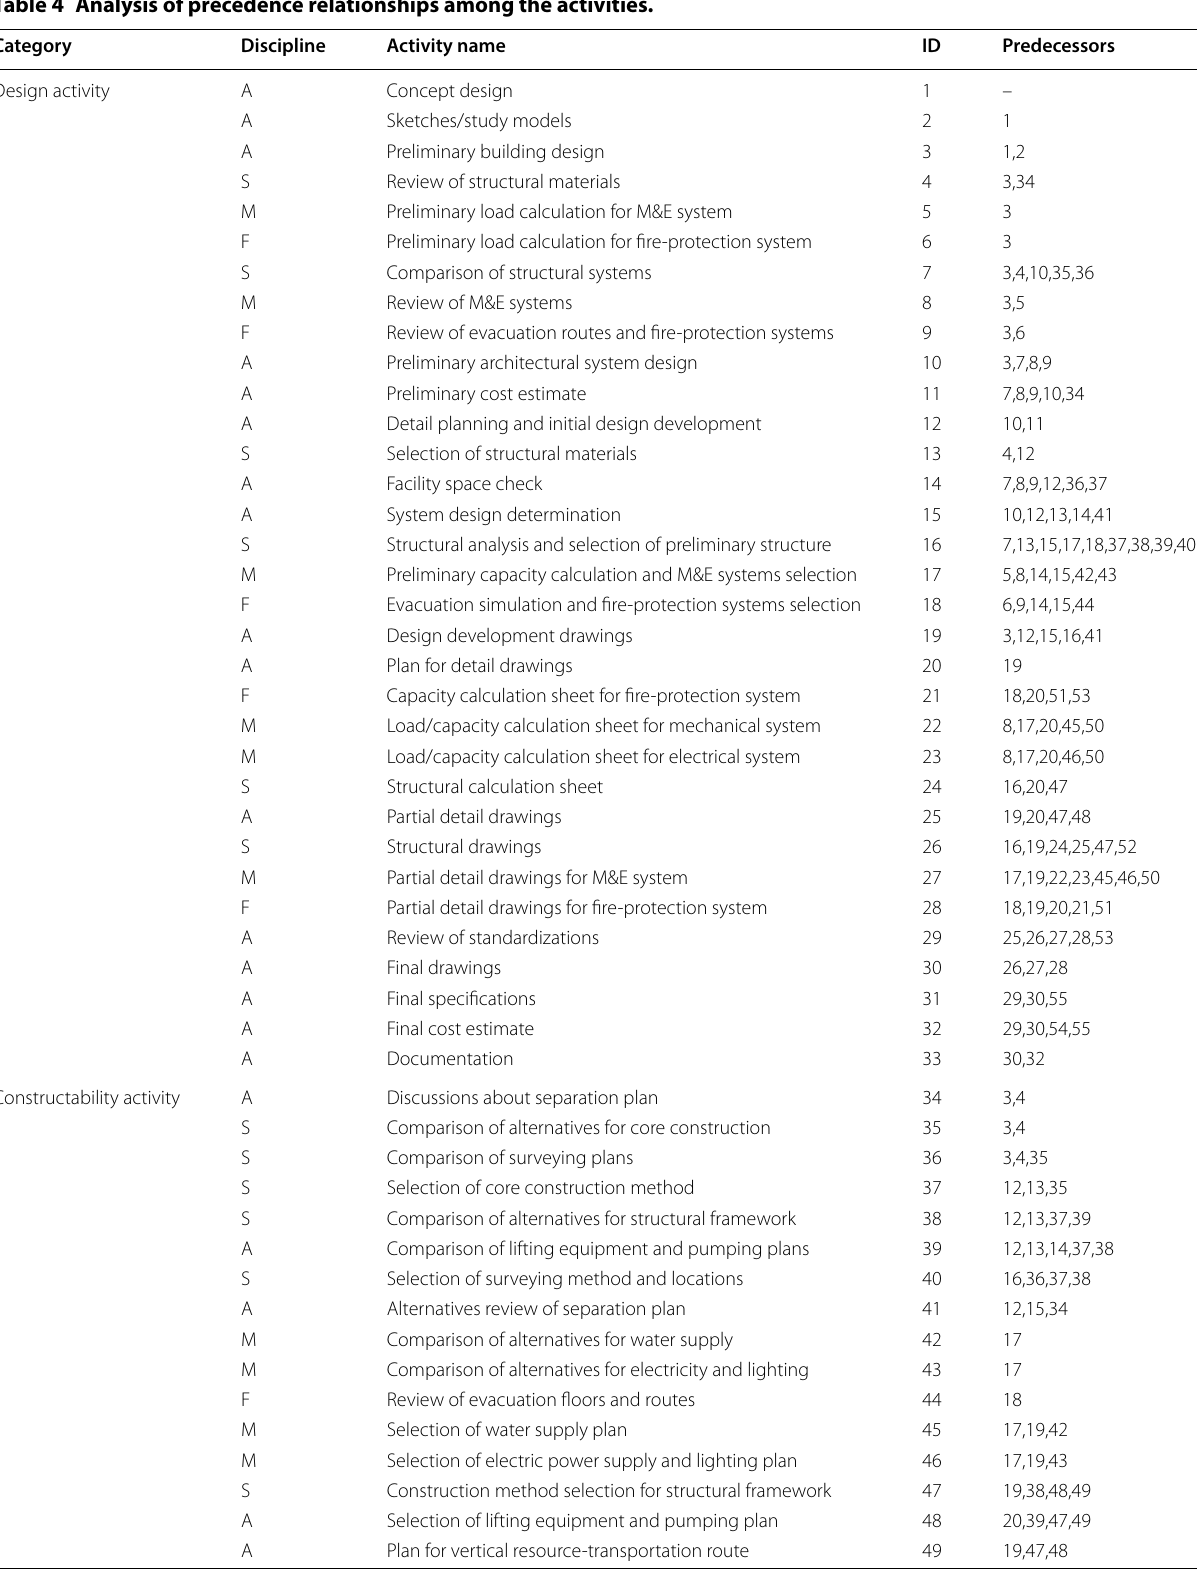
Table 4 Analysis of precedence relationships among the activities. Category Design